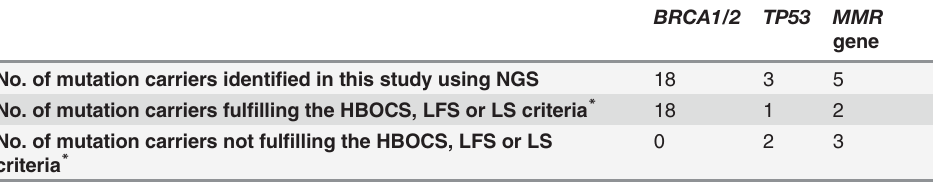
BRCA1/2 TP53 MMR gene 0